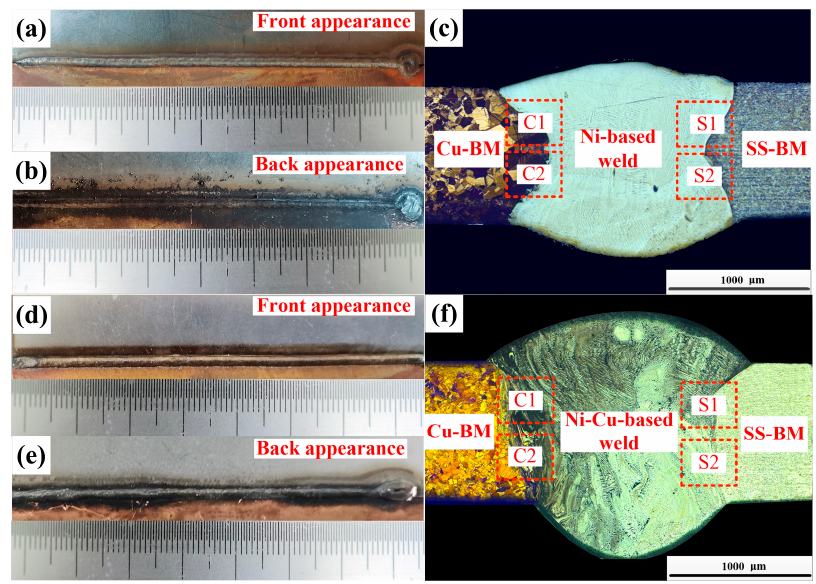
Figure 3. The appearances and the cross-section of the joints.